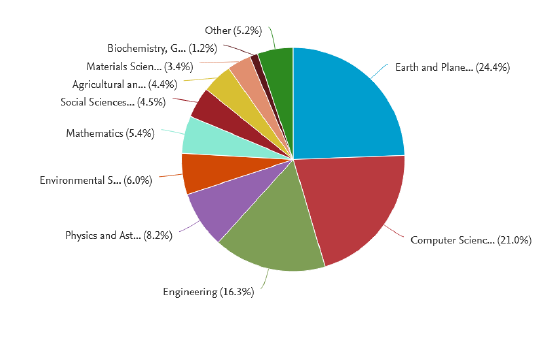
Figure 2. Subject areas of results for query: TITLE-ABS- KEY ("benchmark*" AND ("photogrammetry" OR "remote sensing") ) in Scopus database.